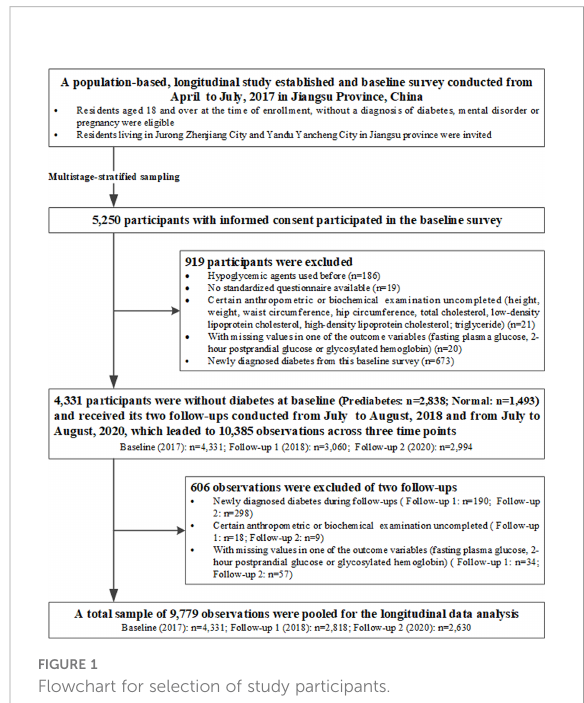
FIGURE 1 Flowchart for selection of study